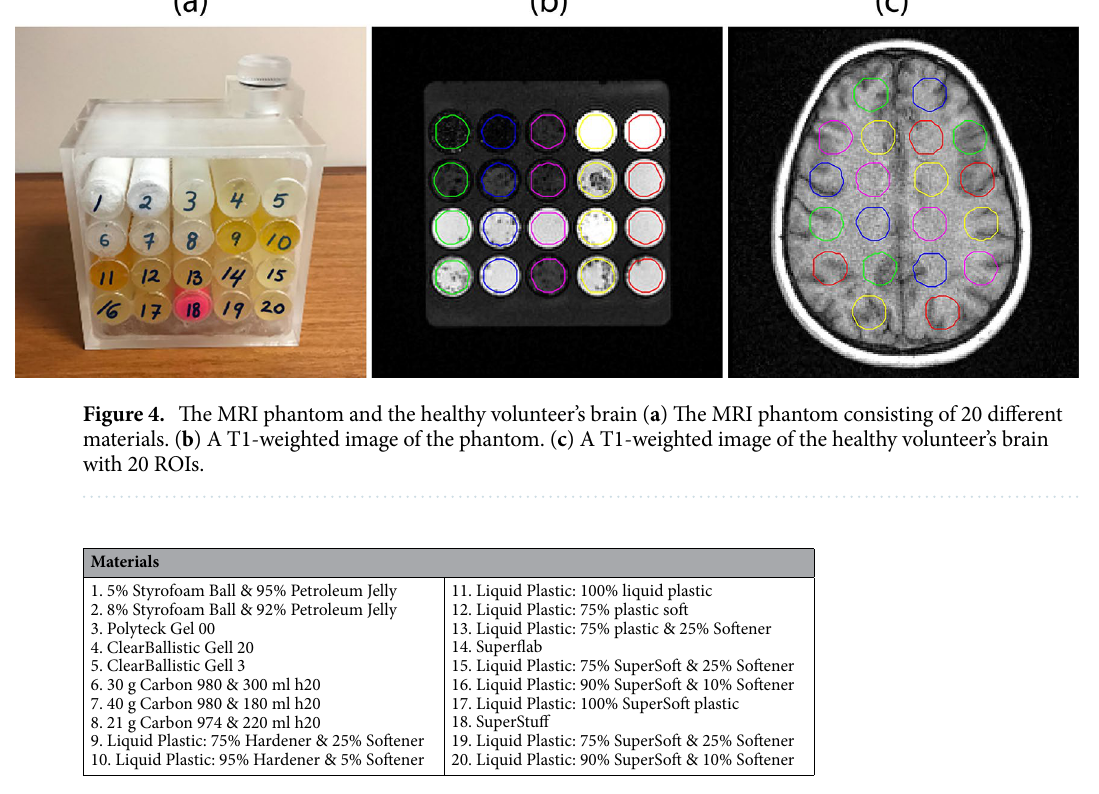
Table 7. The 20 materials used in the MRI phantom.